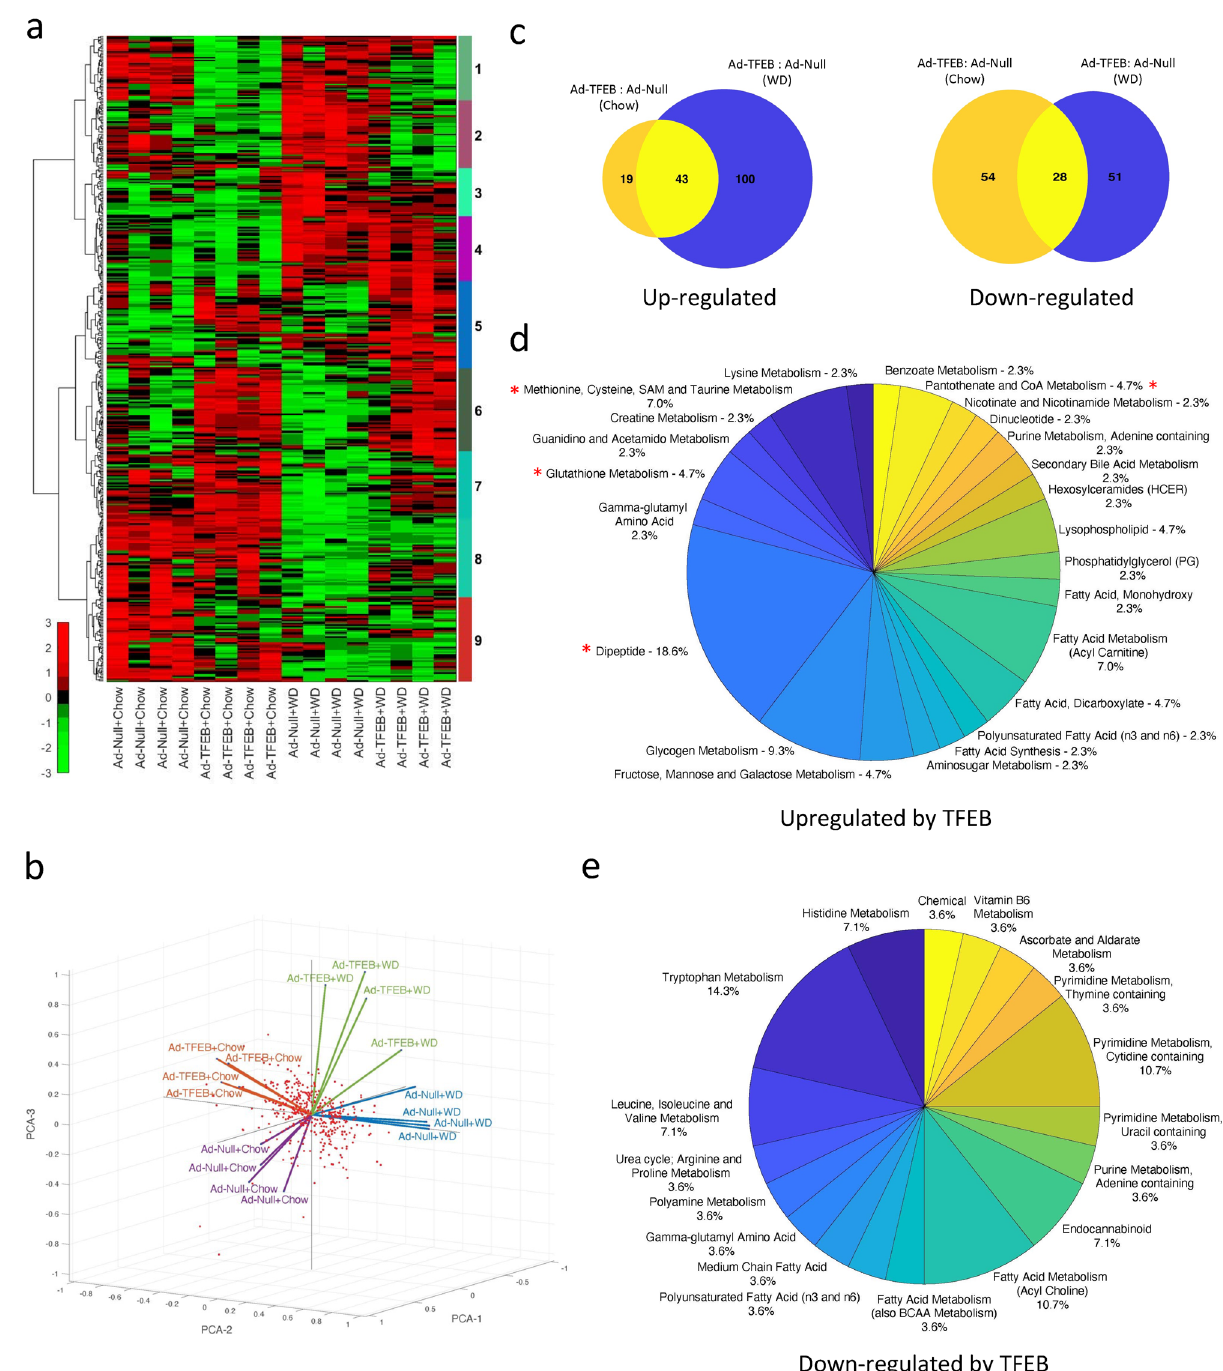
Fig. 1 | Unbiased metabolomics identi fi ed TFEB regulation of hepatic sulfur amino acid metabolism pathways. Male 10 weeks old C57BL/6J mice were intravenously injected with Ad-Null or Ad-TFEB at 5×10 8 pfu/mouse. One week later, mice were fed chow (C) or Western diet (WD) for one additional week. Mice were fasted for6h and euthanized for tissue collection. Liver tissues wereusedfor